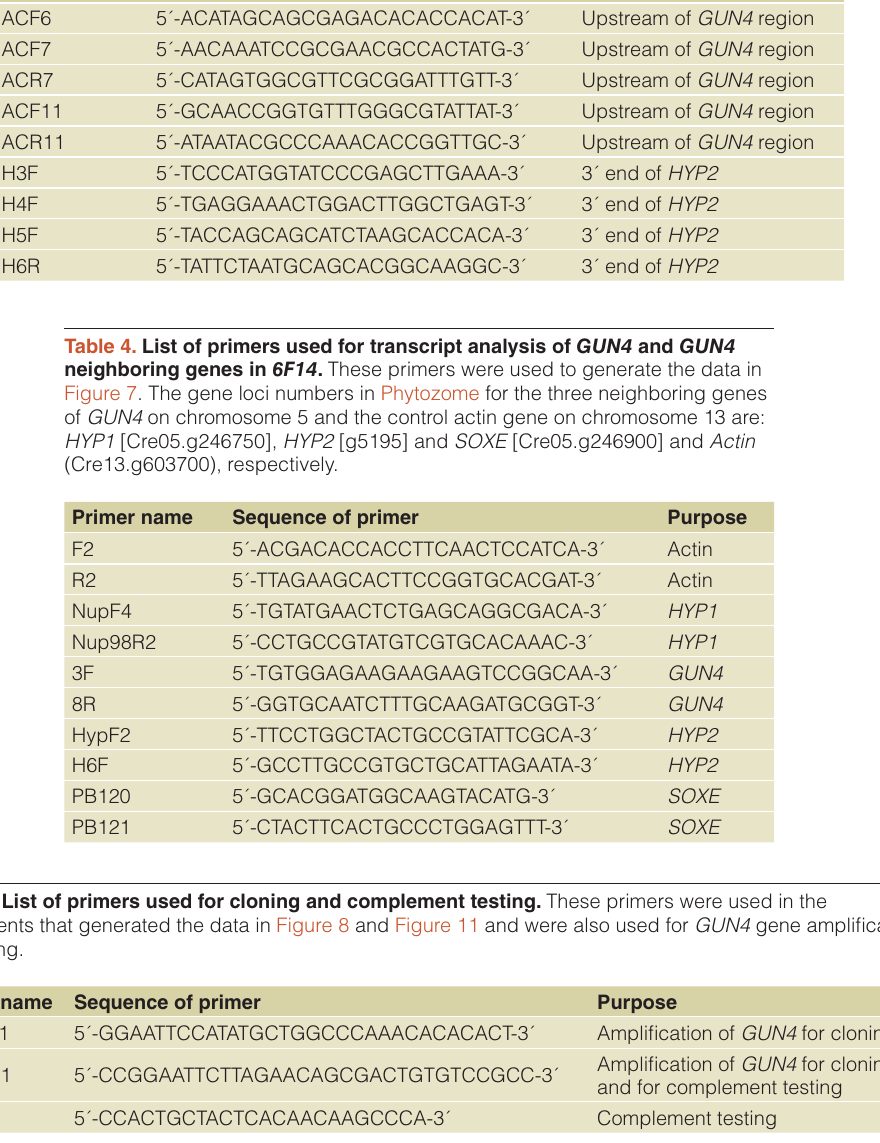
Table 3. List of primers used for checking the genomic region upstream of GUN4 (Cre05.g246800) and HYP2 [g5195] gene. These primers were used to generate the data in Figure S5 and Figure 6.